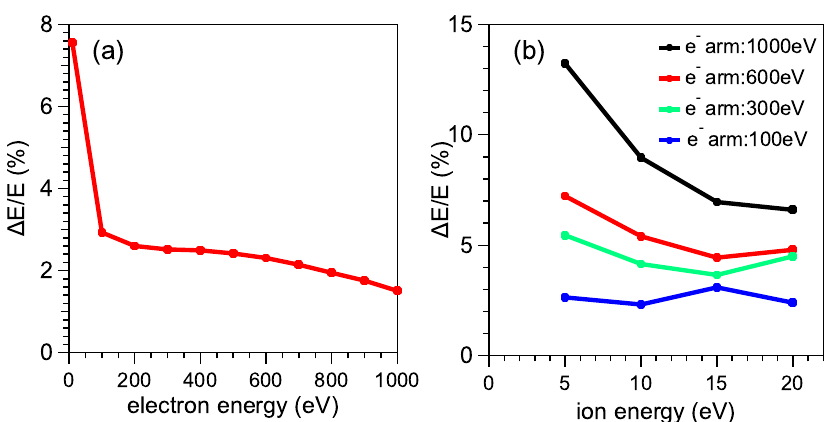
Figure 3. The simulated relative energy resolution ∆ E / E of the CpVMI spectrometer with the electrons or ions emitted at 90 ◦ . ( a ) Relative kinetic energy resolution as a function of electron kinetic energy in the strong focusing mode. ( b ) Relative kinetic energy resolution as a function of ion kinetic energy with the electron arm is set for different kinetic